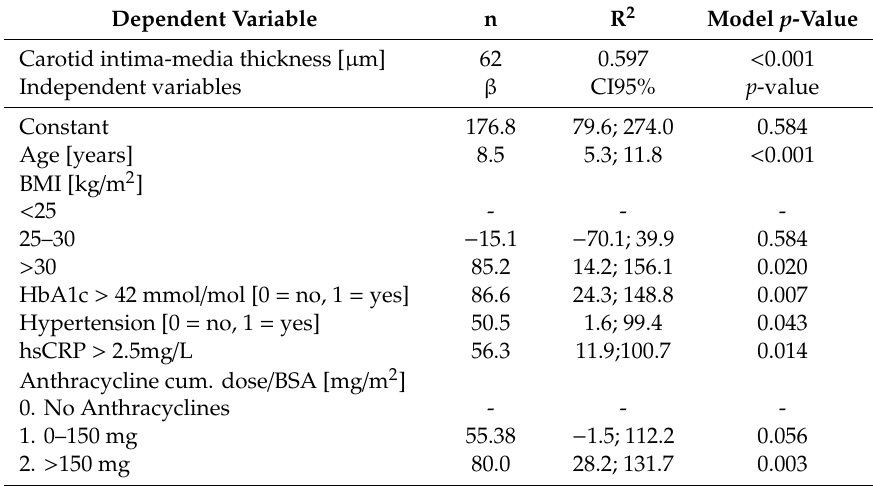
Table 3. ANCOVA model predicting carotid intima-media thickness among